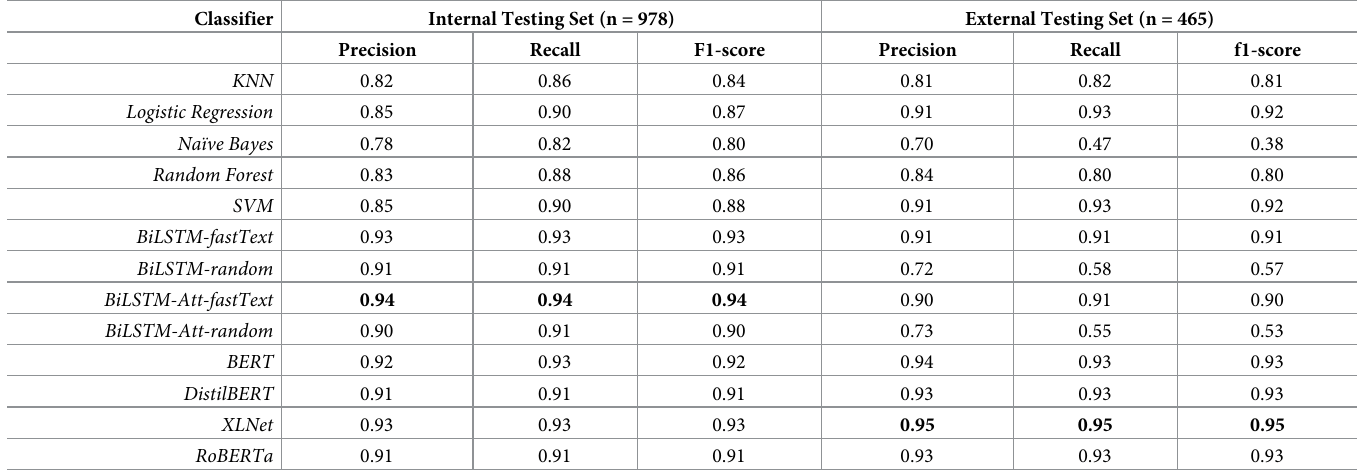
Table 1. Performance comparison of supervised multi-class classifiers on internal and external testing sets. Class-weighted values are reported.